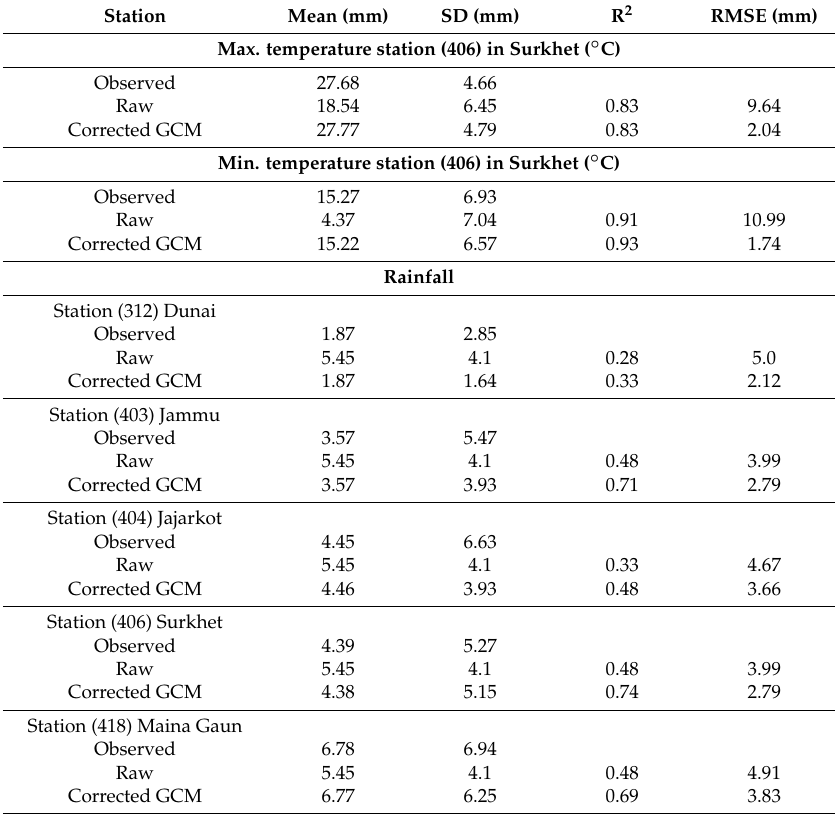
Table 4. Comparison of observed data with raw and corrected MIROC-ESM